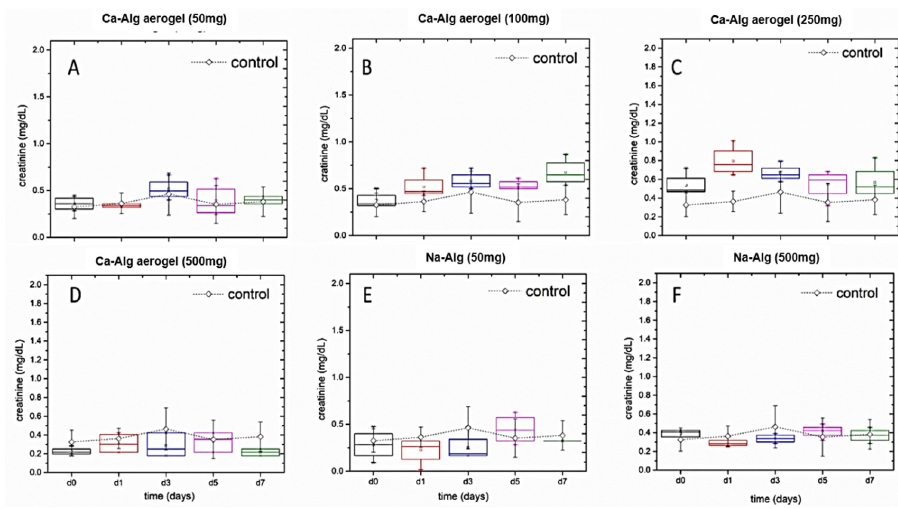
Fig 4. Box-plot for the in vivo serum creatinine level analysis that was done for the different doses of the aerogels and the alginate. The dotted lines in all the panels represent the creatinine values for all the control